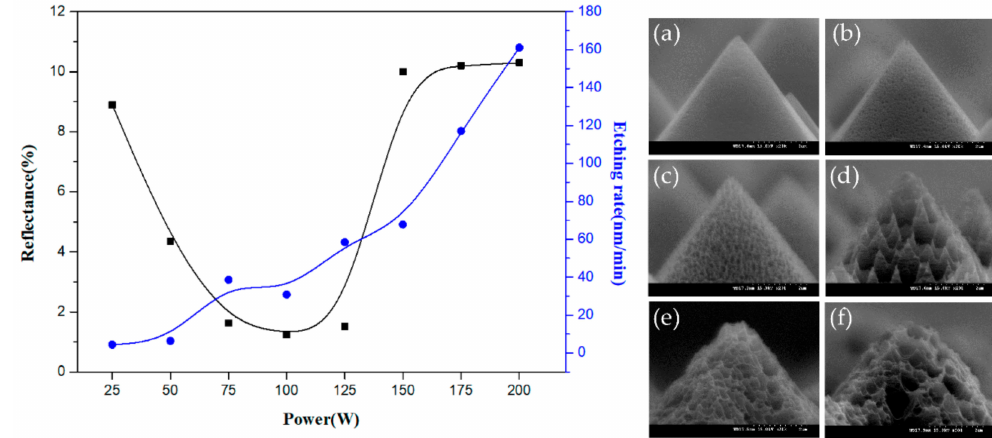
Figure 13. Reflectance and cross-section SEM images of wafer surfaces according to RF power for the two-step etching process with alkali solution and RIE: ( a ) 25 W, ( b ) 50 W, ( c ) 75 W, ( d ) 125 W, ( e ) 150 W, and ( f ) 200